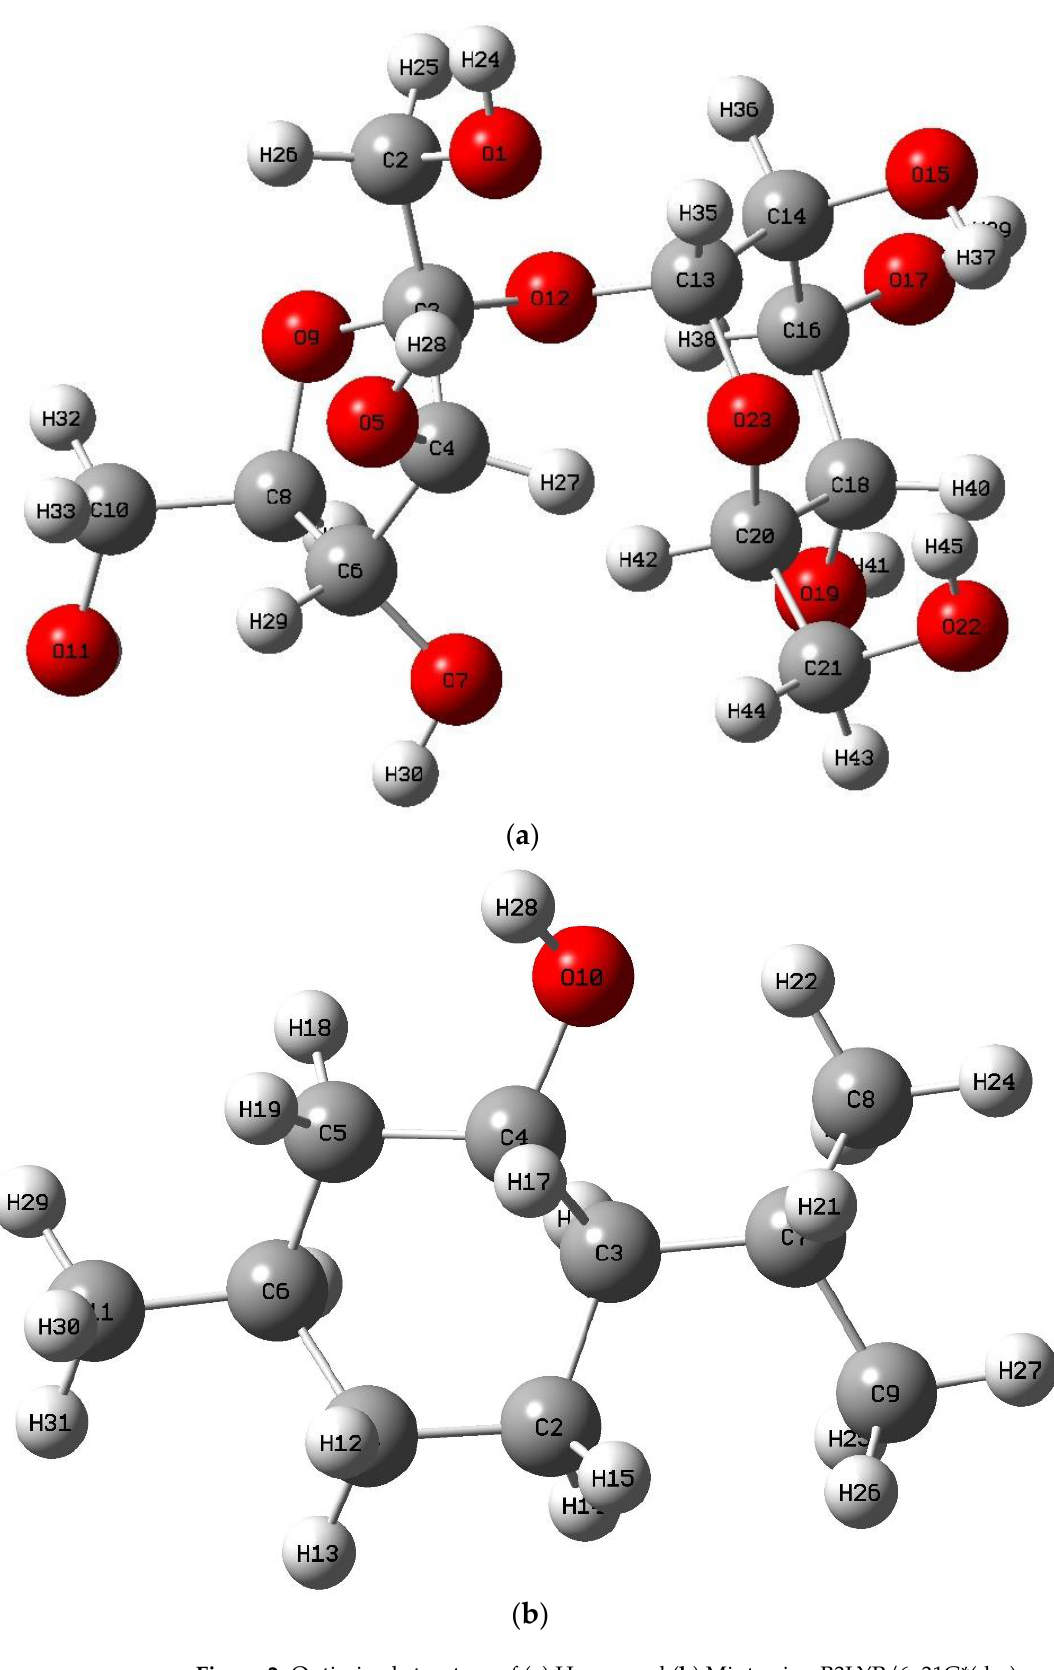
Figure 2. Optimized structure of ( a ) Honey and ( b ) Mint using B3LYP/6 – 31G*(d,p).